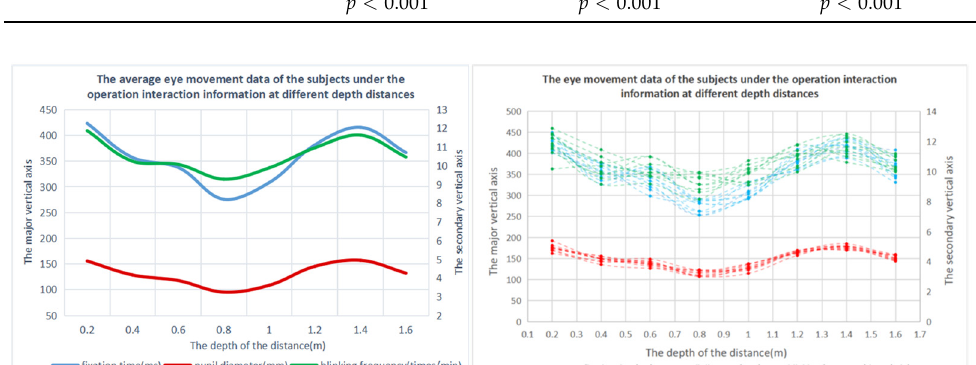
Figure 7. Variation trend chart of eye movement data of operation interaction information at different depths and distances. Table 4. Average time to complete tasks after dividing the depth and distance range of operation interaction information.